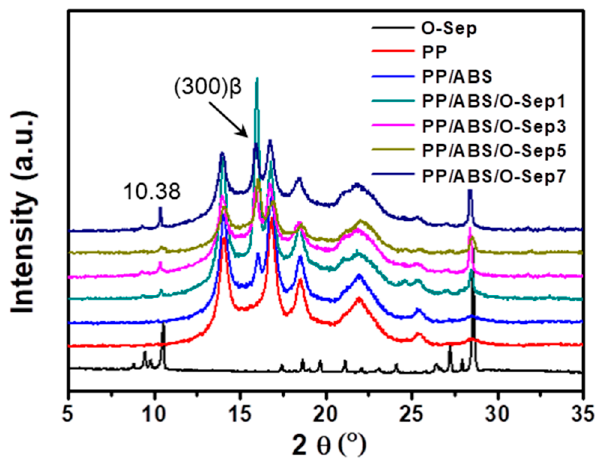
Figure 5. X-ray di ff raction patterns of O-Sep, PP, PP / ABS and PP / ABS / O-Sep nanocomposites.